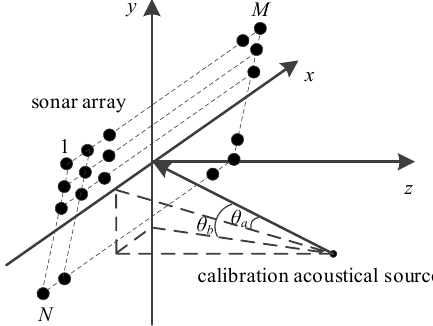
Figure 1. Schematic of the planar array and calibration source.